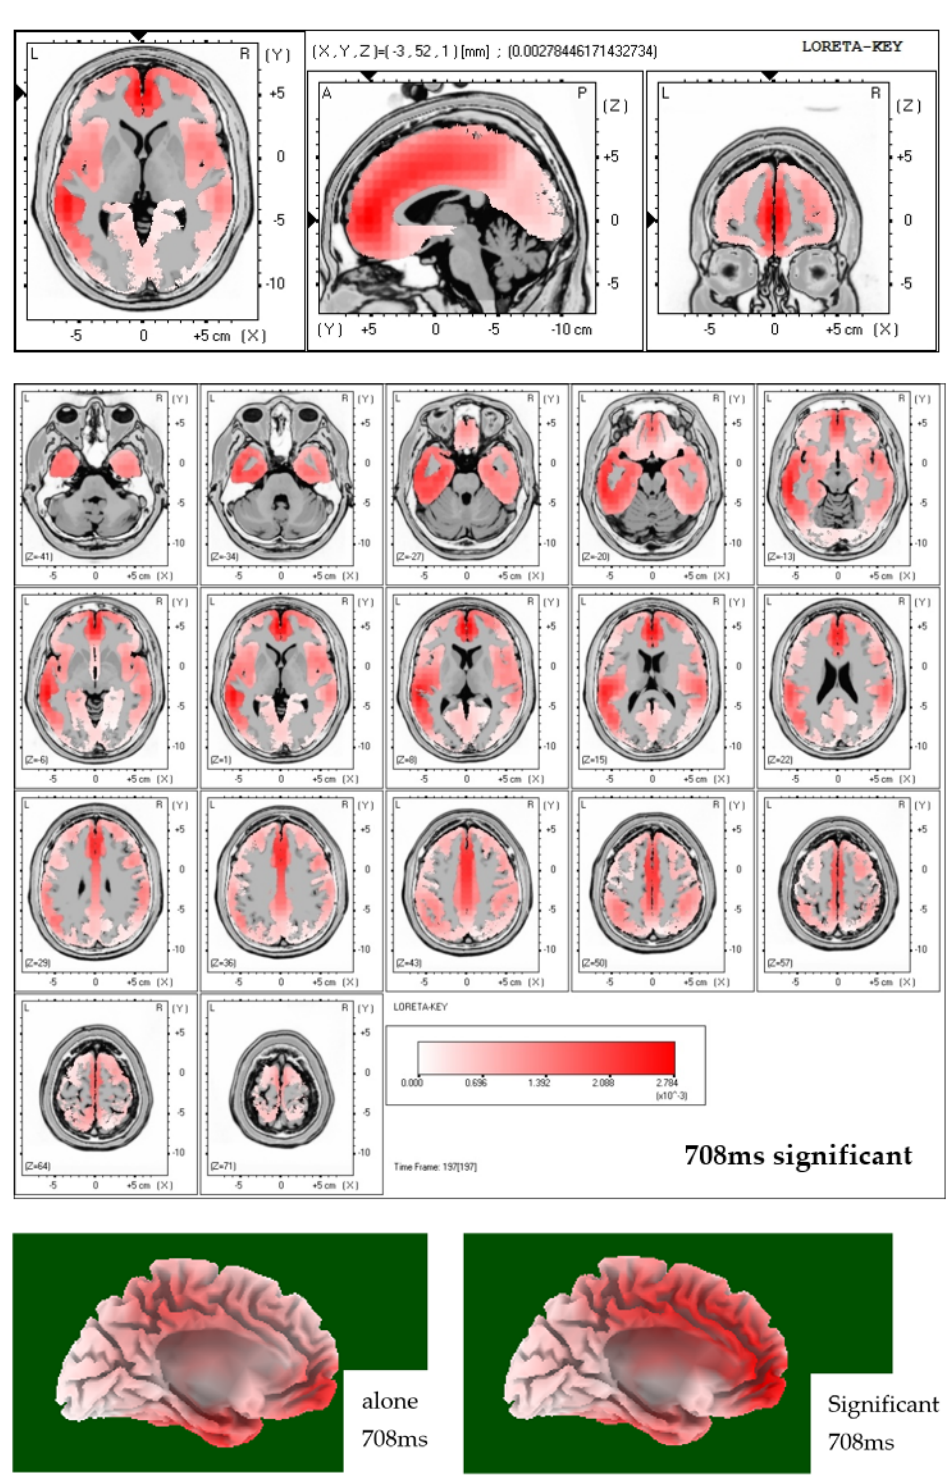
Figure 3. Top two figures: LORETA solutions including all 64 electrodes for both conditions (alone and significant) at 708 ms post ‐ stimulus onset in case of neutral pictures. Note that in the alone condition LORETA calculated maximum activity in the left ‐ temporal region. In the significant other condition, exposure to neutral pictures resulted in maximum activity in the central, frontal region, which can be interpreted as originating within the ACC. Bottom figure: three ‐ dimensional brain displays showing that LORETA solutions calculate maximum brain activation in the significant other condition while viewing neutral pictures to reside within the ACC